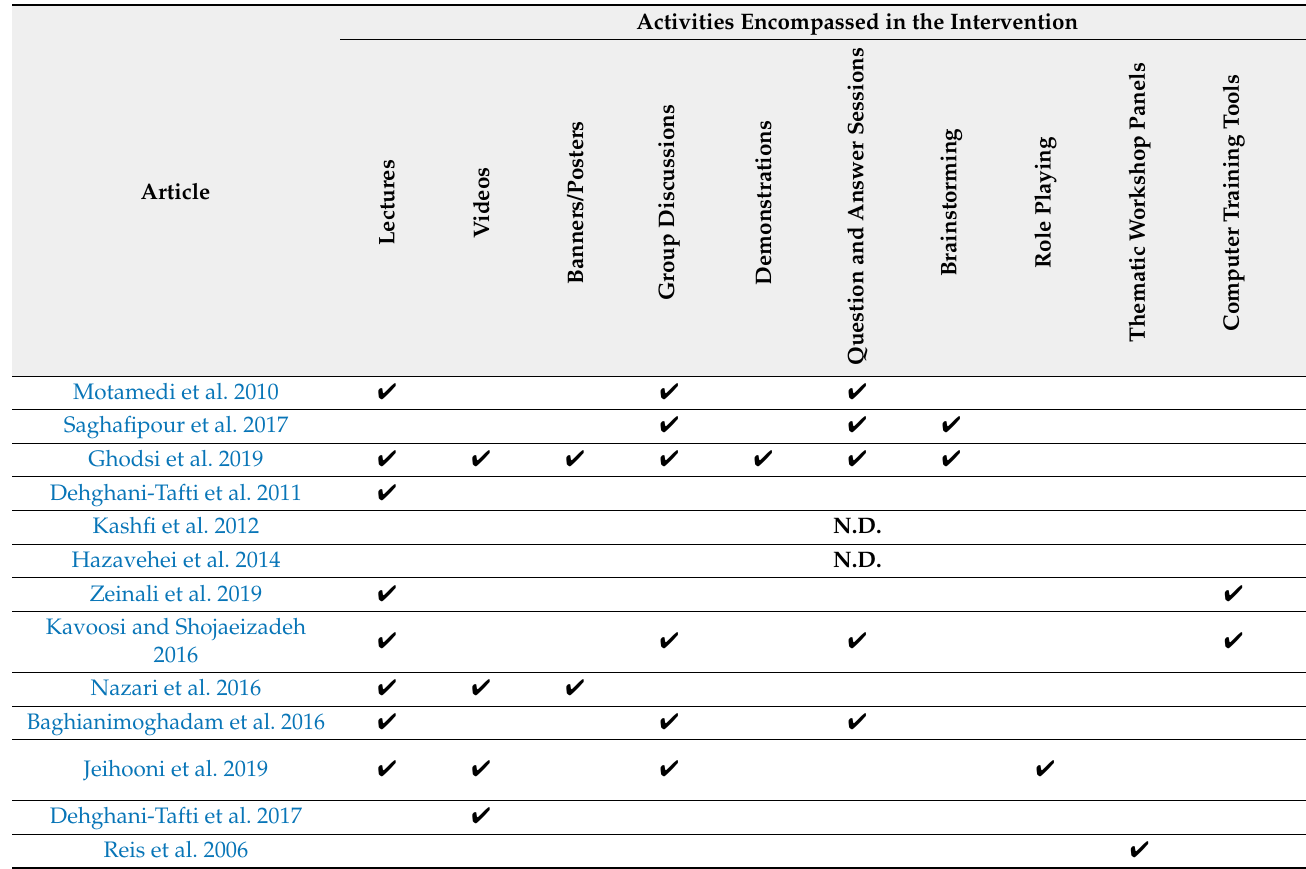
Table 3. Description of educational